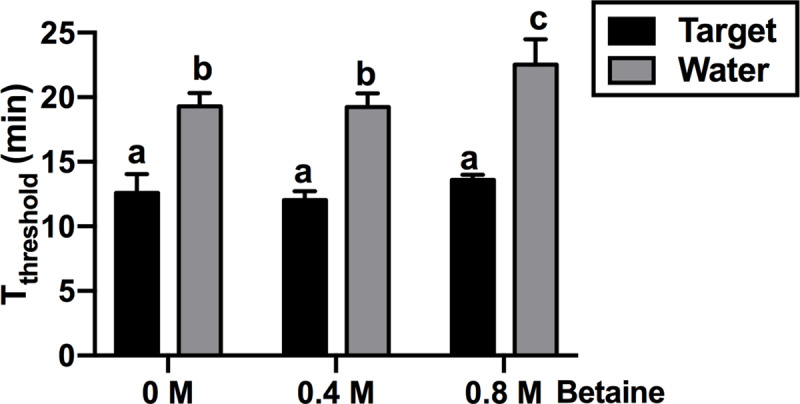
Effect of betaine on RPA amplification.1ng target DNA (black) was added into RPA reactions containing different amount of betaine. Water (grey) was used as controls. The times needed for each sample to reach a fluorescence threshold of 0.05 (Tthreshold) in real-time RPA were analysed using one-way ANOVA (n = 4, p value<0.05). Error bars represent standard deviation.